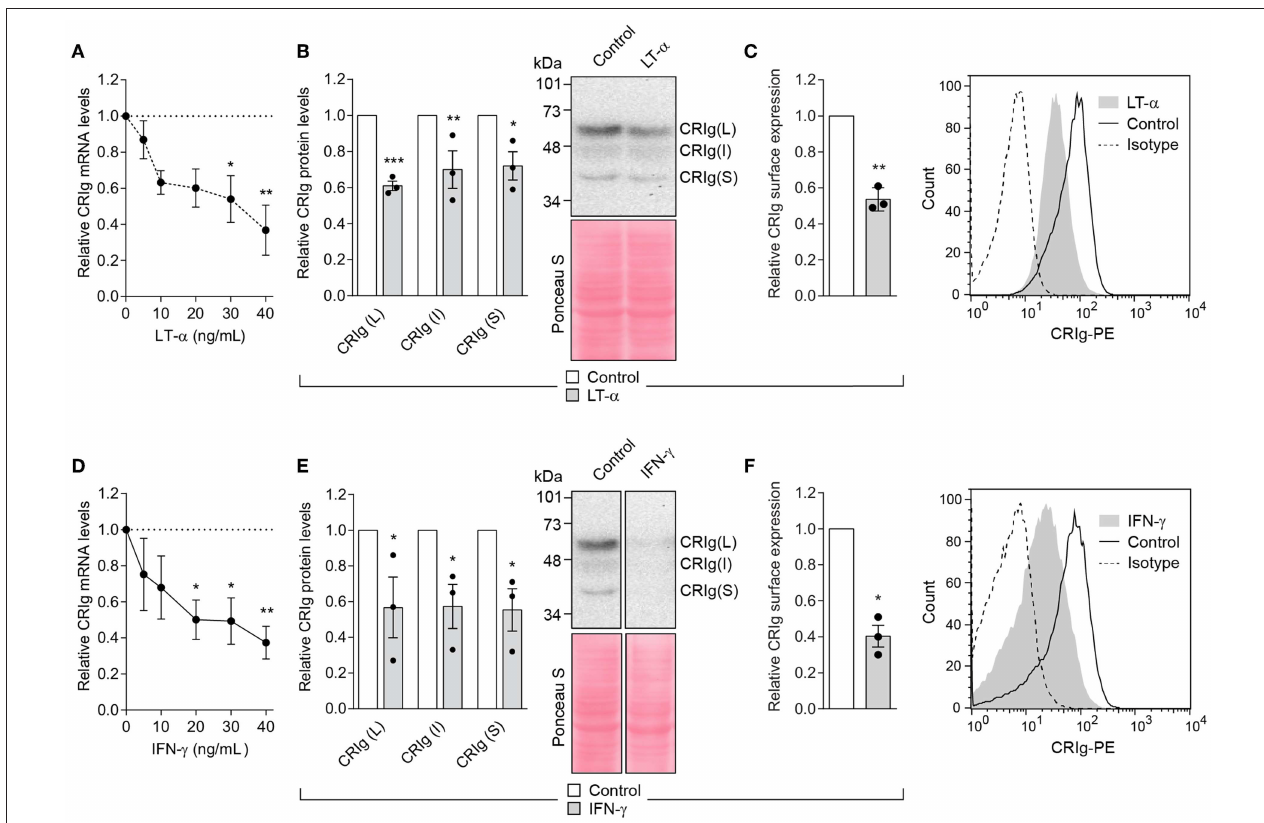
FIGURE 3 | LT- α and IFN- γ decrease CRIg expression in DC. (A,D) DC were treated with varying concentrations of cytokines and the levels of CRIg mRNA determined after 24h of culture. (B,E) In other experiments, CRIg isoform proteins were assessed by Western blot after cells were treated with 40ng/ml of each of the cytokines. (C,F) The effects on cell surface expression of CRIg was examined after a similar treatment. Data are presented as means ± SEM of three experiments, each conducted with cells from different individuals. The blot image (E) was spliced to exclude intervening lanes that represent other treatments and the complete un-spliced blot can be found in Supplementary Figure 2 . Significance levels are indicated by asterisks: * P < 0.05, ** P < 0.01, *** P <